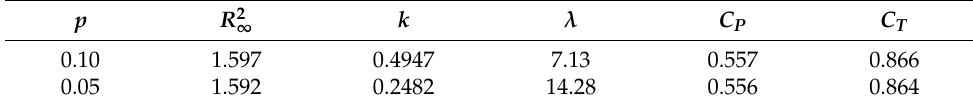
Table 1. Results for the expanding Joukowsky wake with constant pitch. N = 3. p R 2 ∞ k λ C P C T